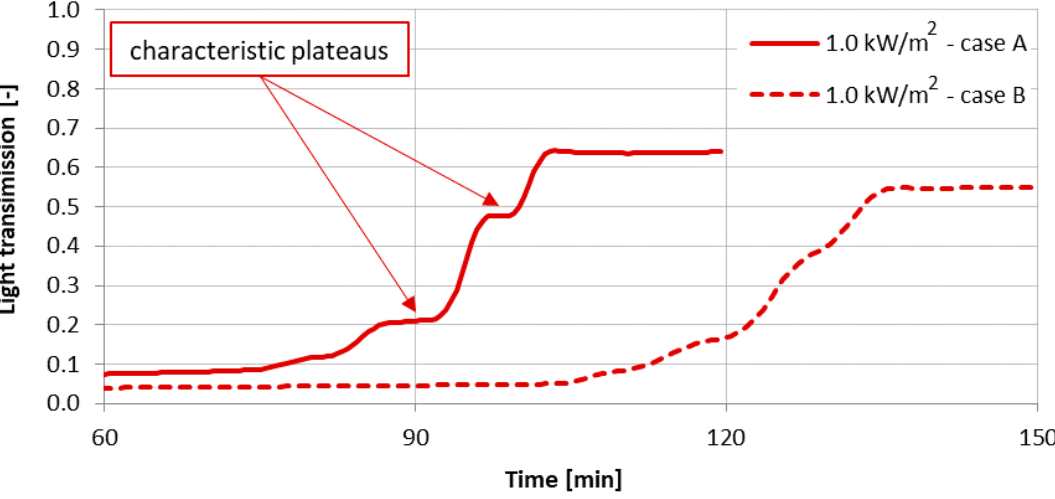
Figure 11. Direct light transmission versus time for a triple glazed window with a PCM layer, 500 W/m 2 . Figure 12. Direct light transmission versus time for a triple glazed window with a PCM layer. 1000 W/m 2 .